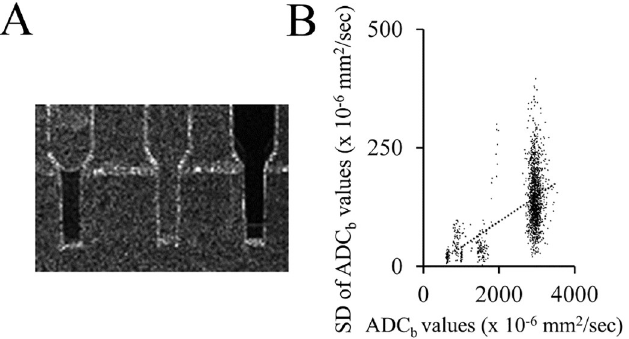
Fig 4. Relationship between ADC values and their SD. (A) SD image of the ADC b values of different phantoms. High-cellularity bio-phantom, physiological saline phantom and 120 mM polyethylene glycol phantom were indicated from left to right. (B) Scatter graph indicating the correlation between the values of ADC b and SD of ADC b . The dotted line indicates a positive correlation as a result of linear regression. ADC, apparent diffusion coefficient; ADC b , ADC basic; SD, standard